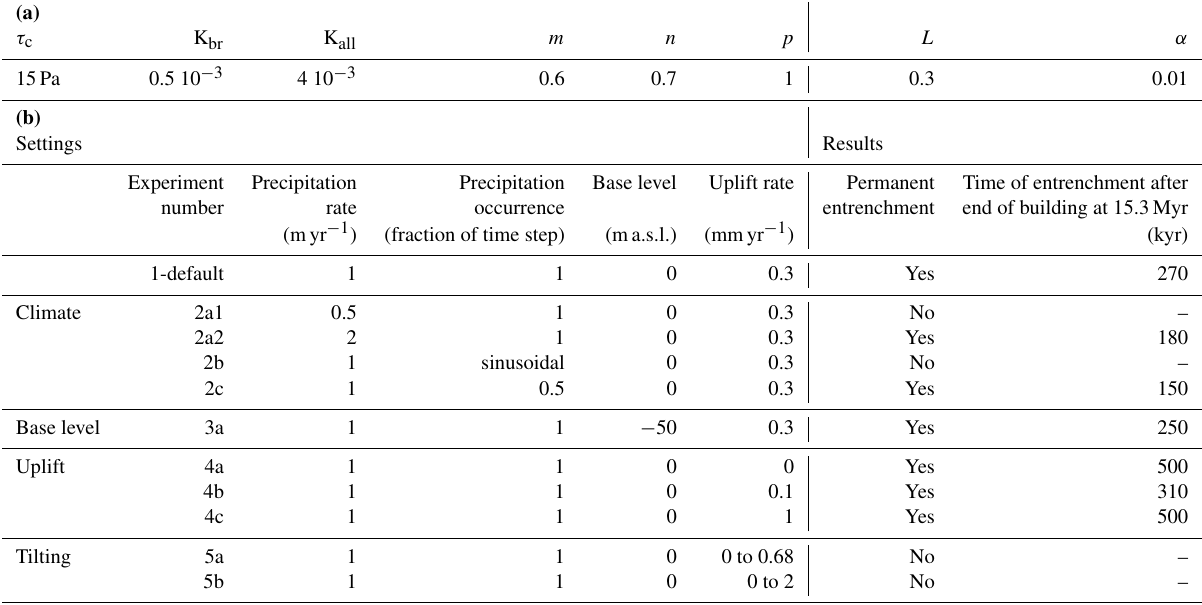
Table 1. Parameters used in the experiments. (a) shows the fixed parameters for all model runs. τ c is the critical shear stress; K br and K all are the bedrock and sediment erodibility respectively; m , n , and p are coefficients for the fluvial erosion law; L is the transport length; and α is the lateral erosion coefficient. (b) shows the model settings for the experimental runs and